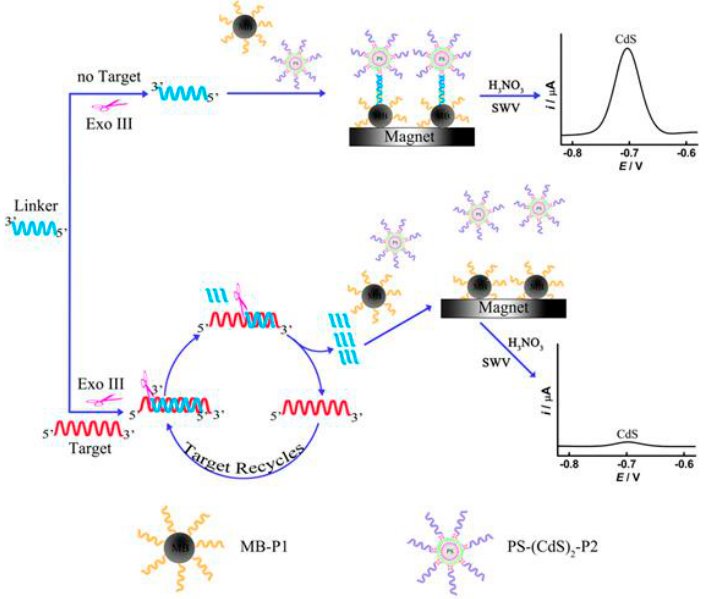
Figure 7. Schematic image of the duplex amplification process using enzymatic recycling and the layer-by-layer PS–(CdS) 2 assemblies. Reproduced from [64], with permission from Elsevier, 2019.